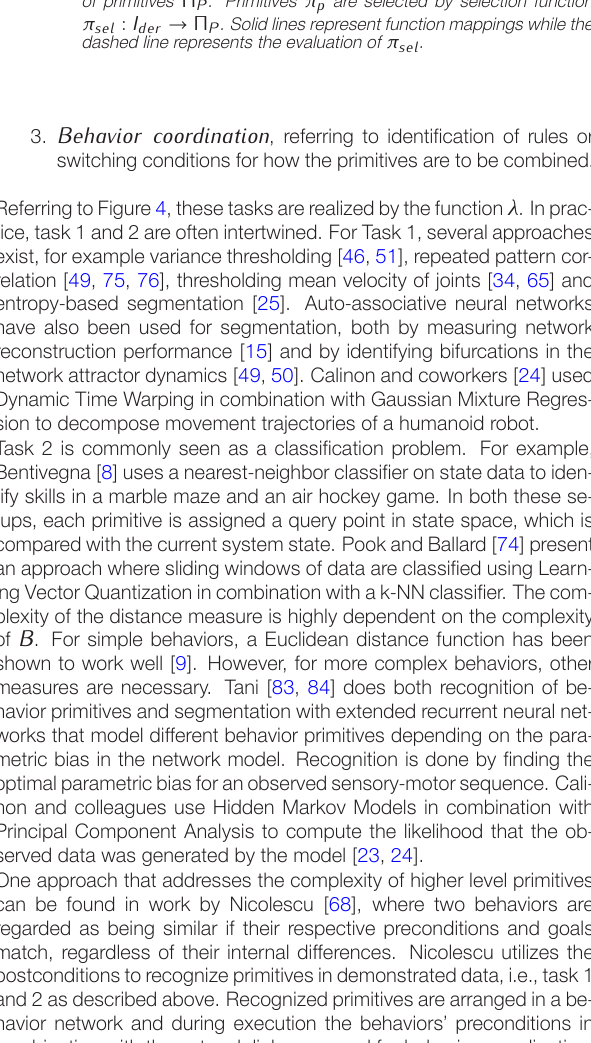
3. Behavior coordination , referring to identification of rules or switching conditions for how the primitives are to be